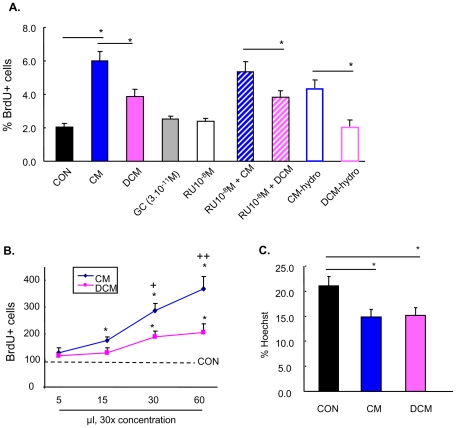
Conditioned medium from GC-treated astrocytes influences neurogenesis in hippocampal cultures.
A, Treatment of primary hippocampal cultures with DCM (conditioned medium harvested from GC-treated astrocytes) attenuated the mitotic effects of CM (conditioned medium from normal astrocytes), measured by BrdU incorporation and Ki67 immunostaining. Conditioned media were prepared by either serial concentration (to reduce dexamethasone concentrations to <3.10−11 M; CM and DCM) or physical absorption of dexamethasone (CM-hydro and DCM-hydro). The effects of DCM could not be antagonized with GR antagonist, RU38486 (10−8 M). Neither dexamethasone (3.10−11 M) nor RU38486 (10−8 M) exerted significant effects on neural proliferation, and DCM-hydro attenuated the mitotic effects of CM-hydro to similar extents. B, CM caused a dose-dependent increase in neural proliferation, whereas DCM reduced the stimulatory effects of CM. C, Apoptosis in primary hippocampal cells in culture were reduced by CM and DCM to similar extents. Numerical data represent mean ± SD. * p<0.05 vs. CON, + p<0.05 vs. corresponding CM group.